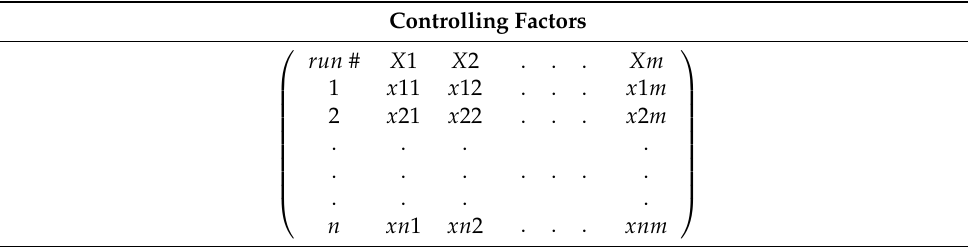
Table 1. A general arrangement of an OA matrix.